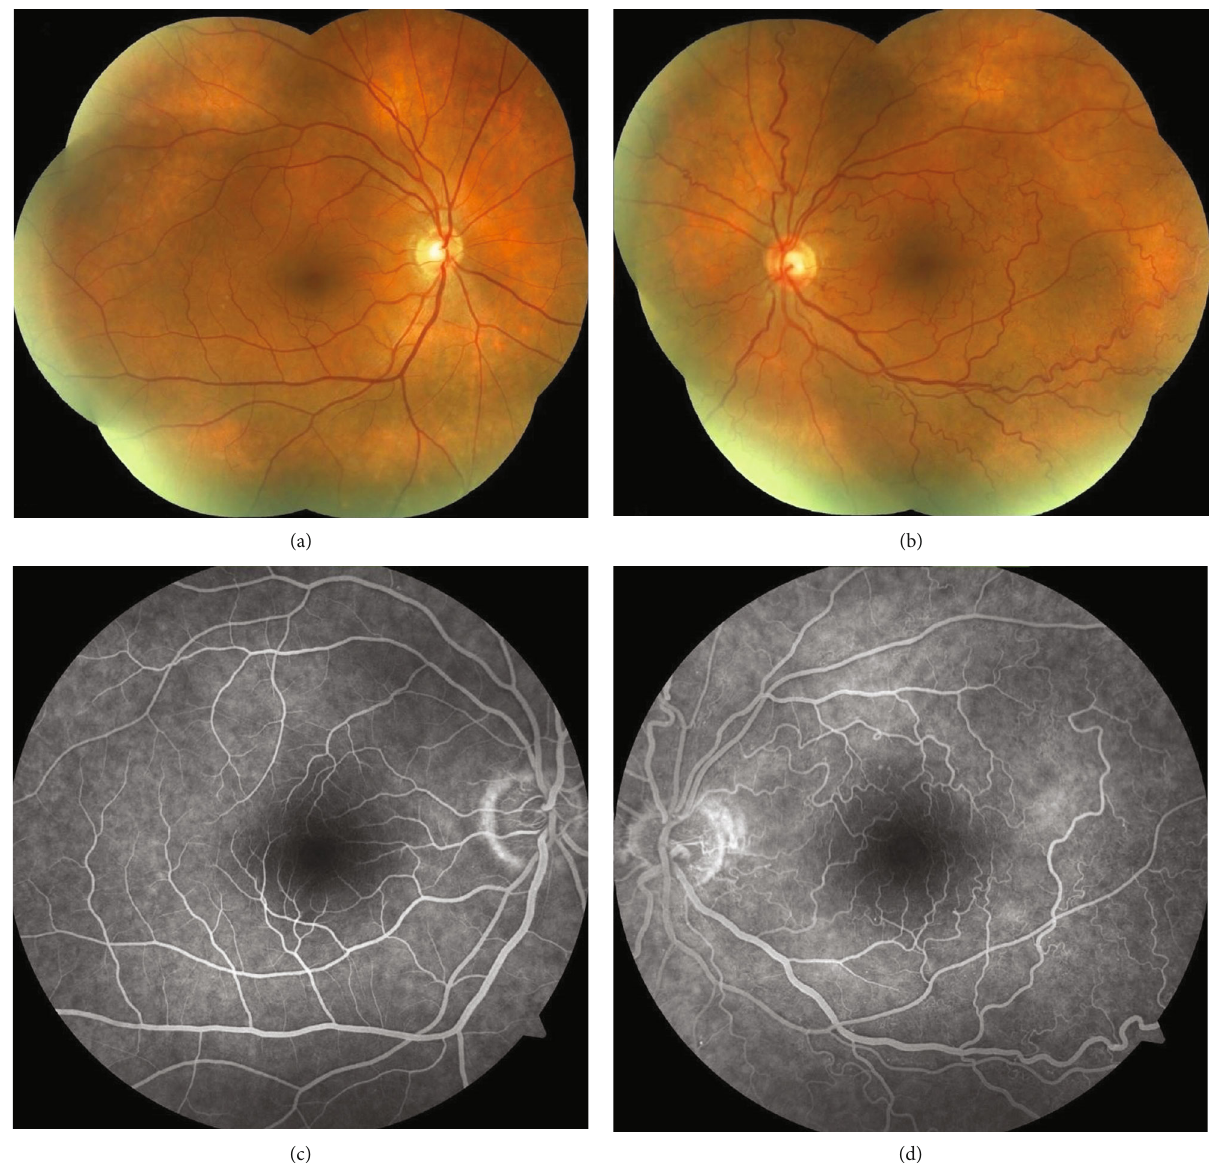
Figure 2: Colour fundus photograph of the right (a) and the left (b) eyes. Fundus fl uorescein angiography of the right (c) and the left (d) eyes, showing normal retinal vasculature on the right and the convoluted and slightly dilated arteries and veins on the left